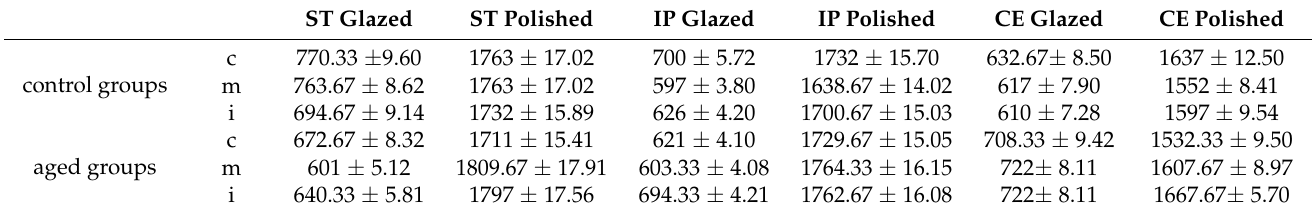
Table 8. Mean Vickers hardness values with SD, for all samples (n = 8).